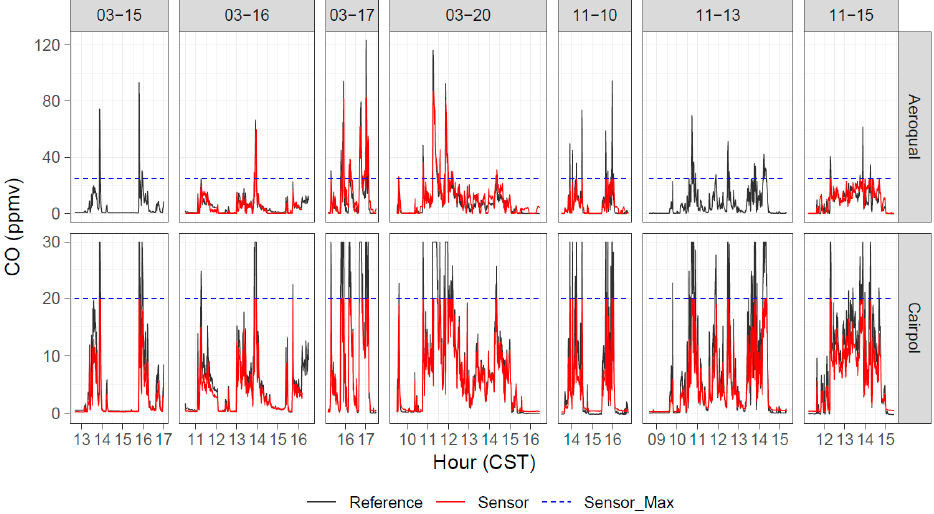
Figure 5. Timeseries of reference, Aeroqual, and Cairpol CO measurements during seven days of Tallgrass Prairie prescribed burn experiments in 2017.